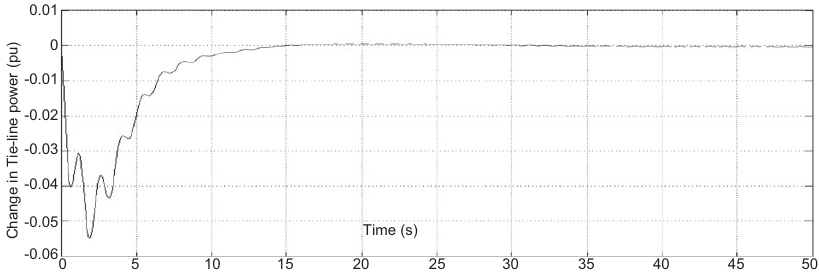
Figure 20. Change in Tie-Line Power (Hydro Plant): With ANFIS Controller.